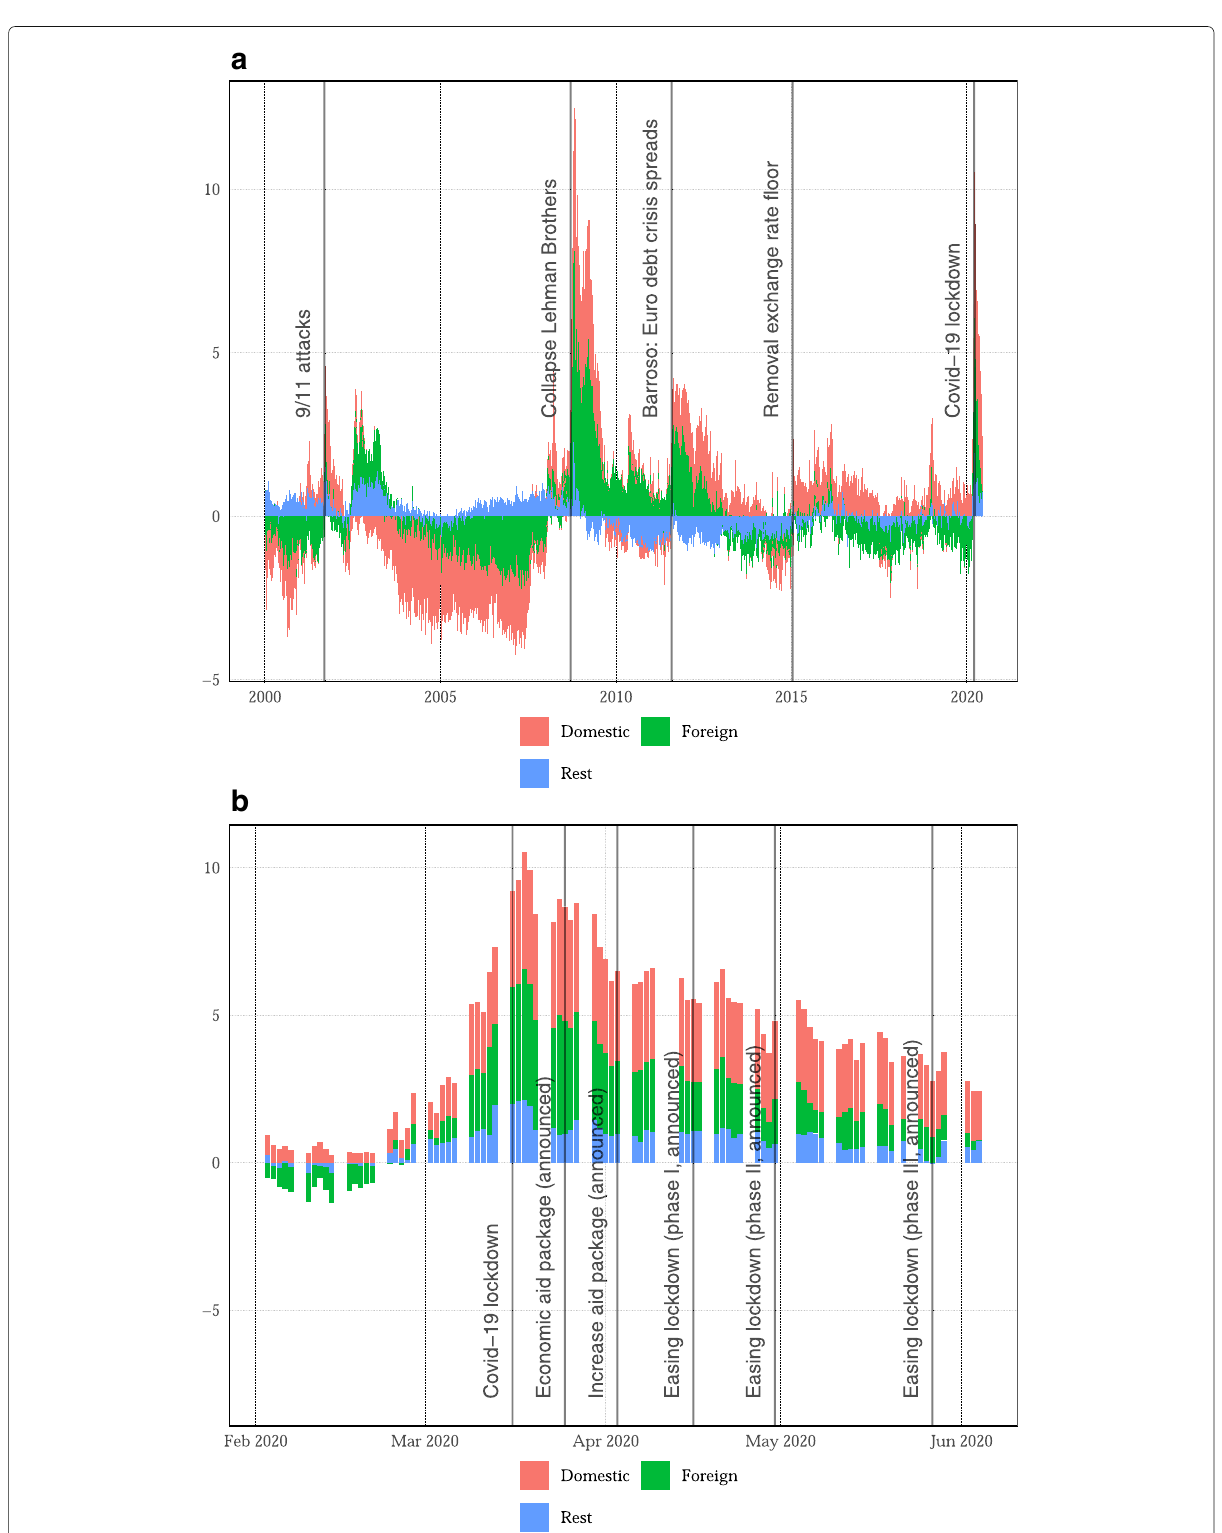
Fig. 3 Decomposition domestic and foreign variables. Decomposition of the f -curve into foreign factors, domestic factors, and an unexplained